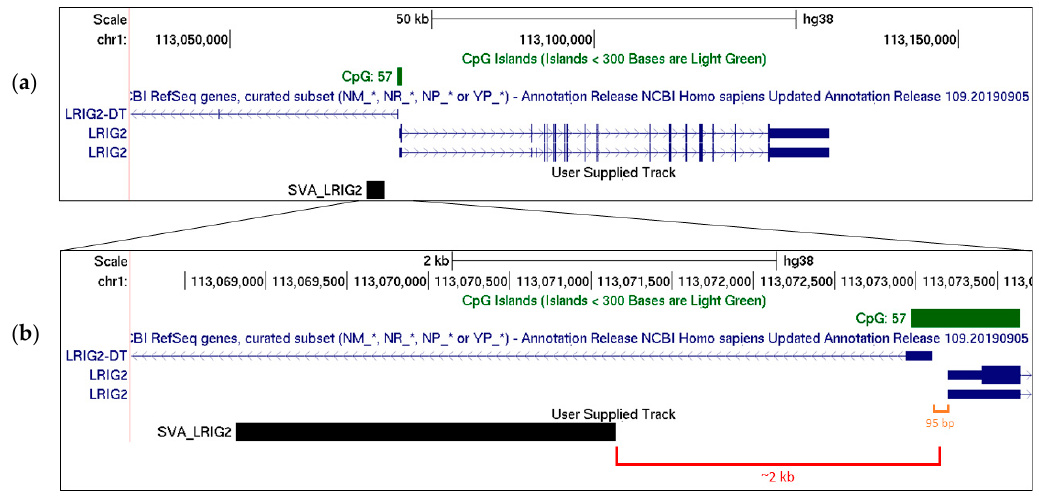
Figure 2. ( a ) The LRIG2 locus as shown on UCSC genome browser hg38, displaying two validated LRIG2 isoforms and first exon of LRIG2-DT from the RefSeq genes curated subset, and the LRIG2 promoter-associated CpG island. SVA_LRIG2 position is displayed. ( b ) Regions flanking SVA_LRIG2 are displayed, with distance to LRIG2 locus transcriptional start sites highlighted in red. Distance between LRIG2 and LRIG2-DT transcriptional start sites highlighted in orange.